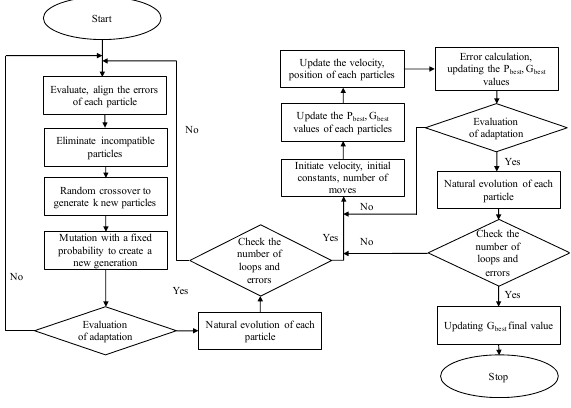
Figure 7. The combination method of Q. Zhang repoduced from [15], Appl. Energy: 2016 .